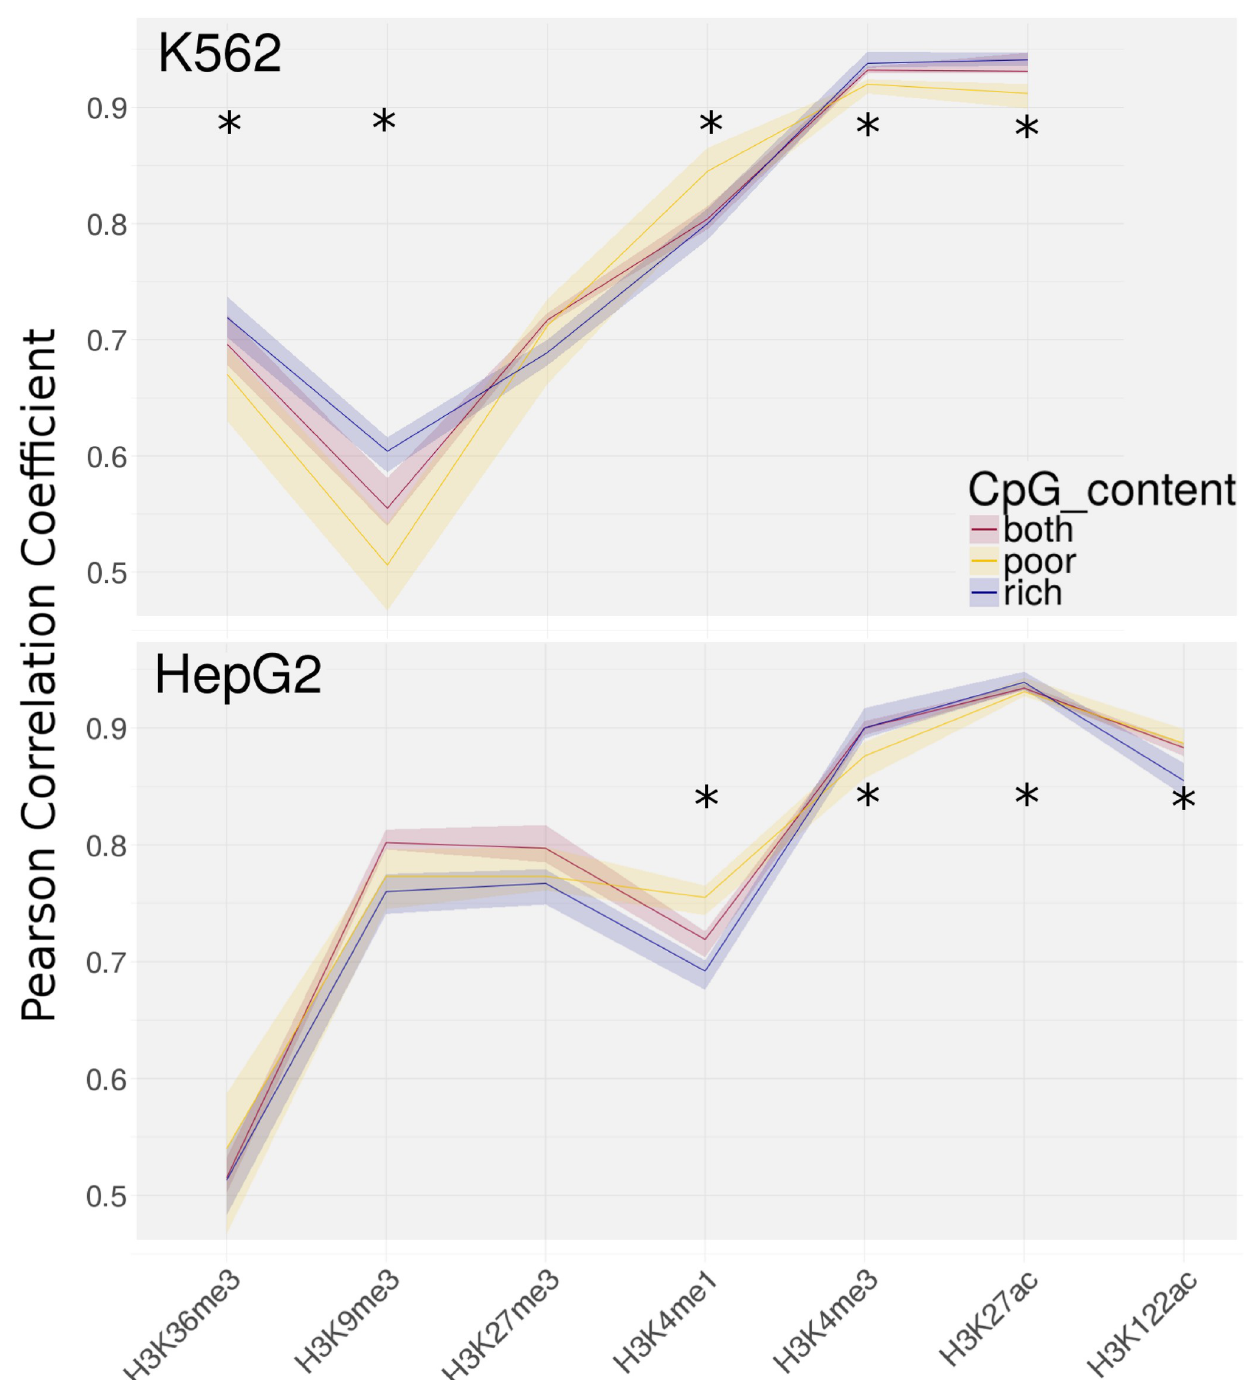
Fig 4. Overall model performance measured as Pearson correlation (y-axis) between predicted and actual response across test sets of outer folds of cross validation for each of the models. Mean correlation coefficient of the 5 folds is indicated by a solid line, range of obtained correlation values across folds is given as the transparent area. We receive one model for each combination of cell line (top plot HepG2, bottom plot K562), CpG type (given by the color encoding), and Histone modification (encoded on the x-axis). Significant differences of performance between CpG rich and poor model according to a Wilcoxon test ( α = .05, Benjamini-Hochberg corrected) are indicated by asterisks ( � ).